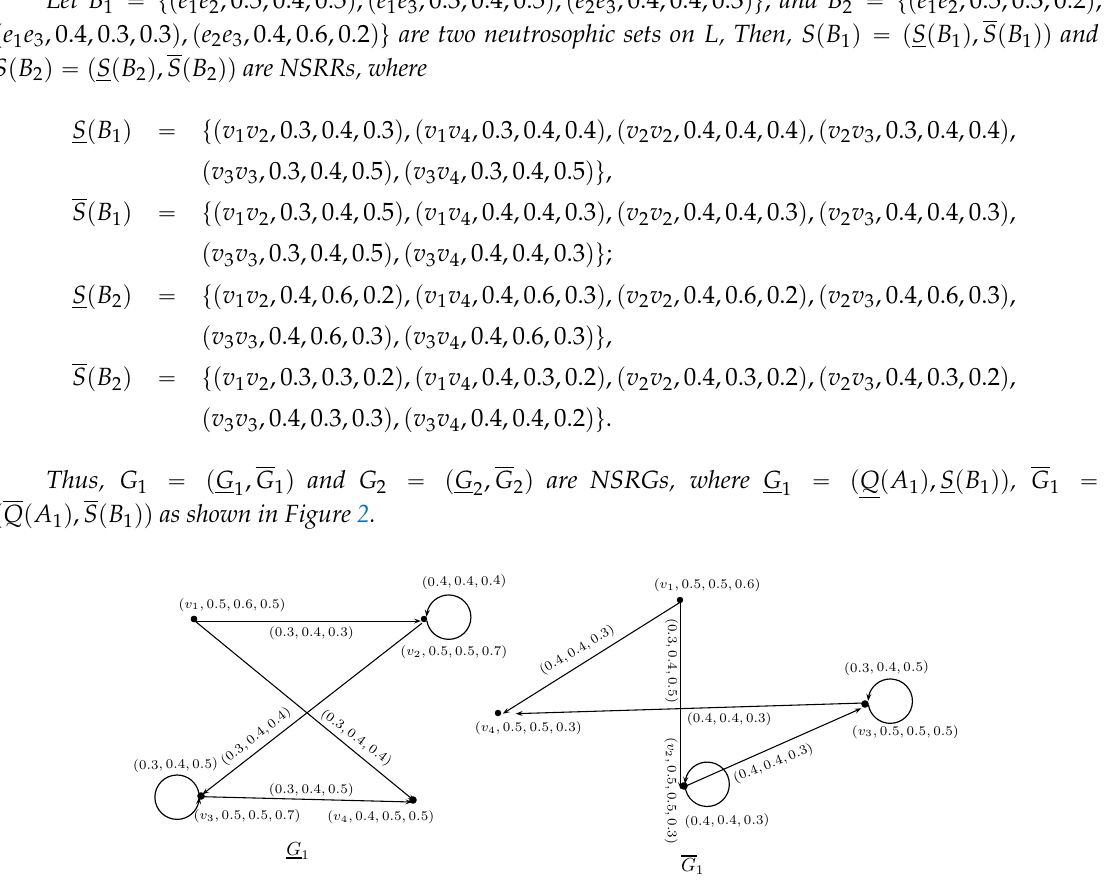
Figure 2: Neutrosophic soft rough graph G 1 = ( G Figure 2. Neutrosophic soft rough graph G 1 “ p G 1 , G 1